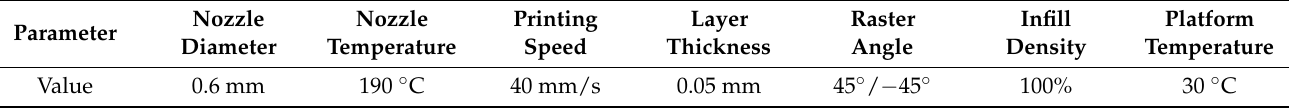
Table 1. Three-dimensional printing parameters used in the sample